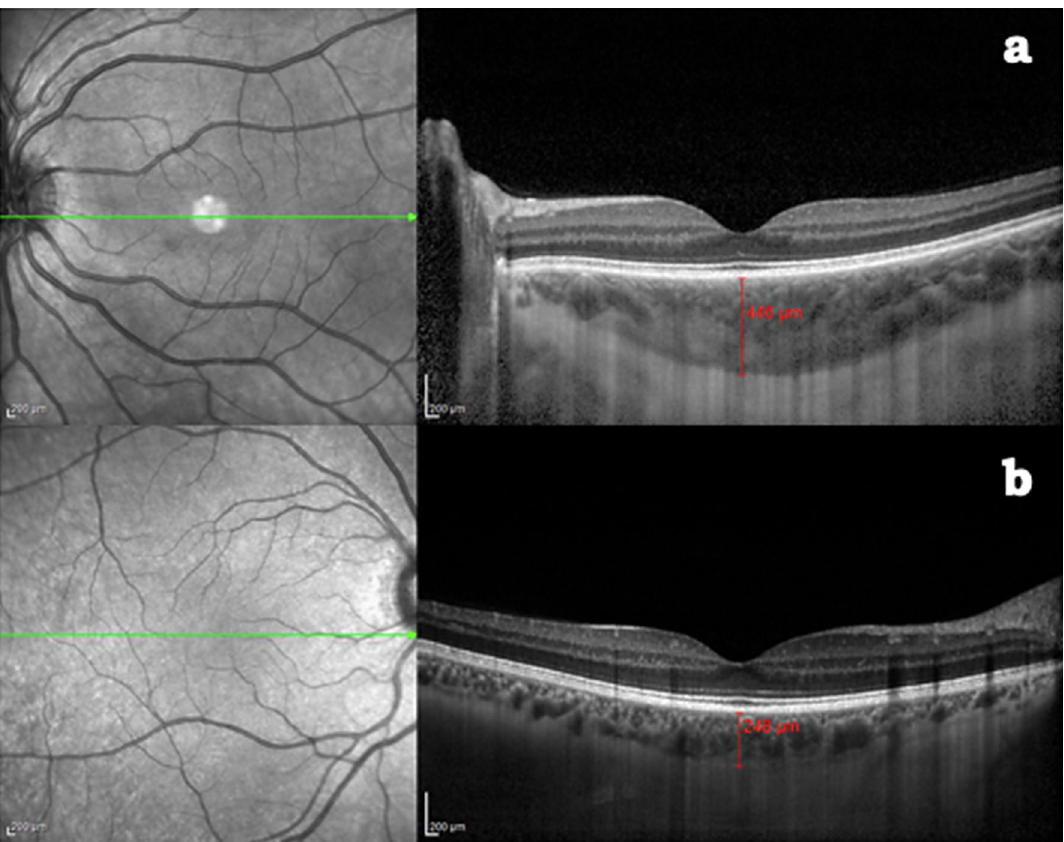
Figure 1. Choroidal thickness measured with the built-in software of the device at the subfoveal level in: ( a ) celiac patient. ( b ) Healthy